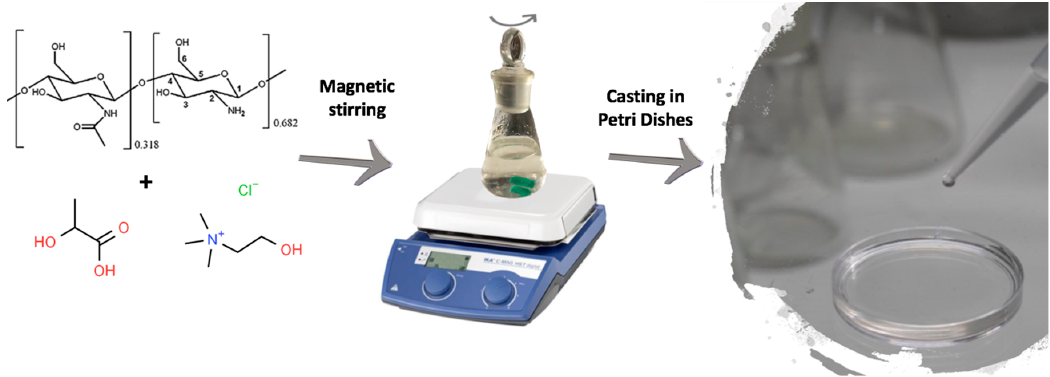
Figure 1. Schematic illustration of the preparation of chitosan-lactic acid-choline chloride (CS-LA-ChCl) films.